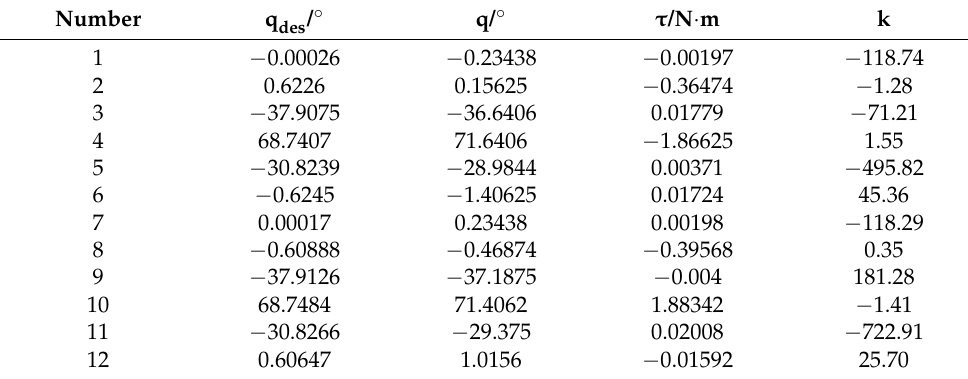
Table 2. Specific parameters of Roban robot’s steering gears.